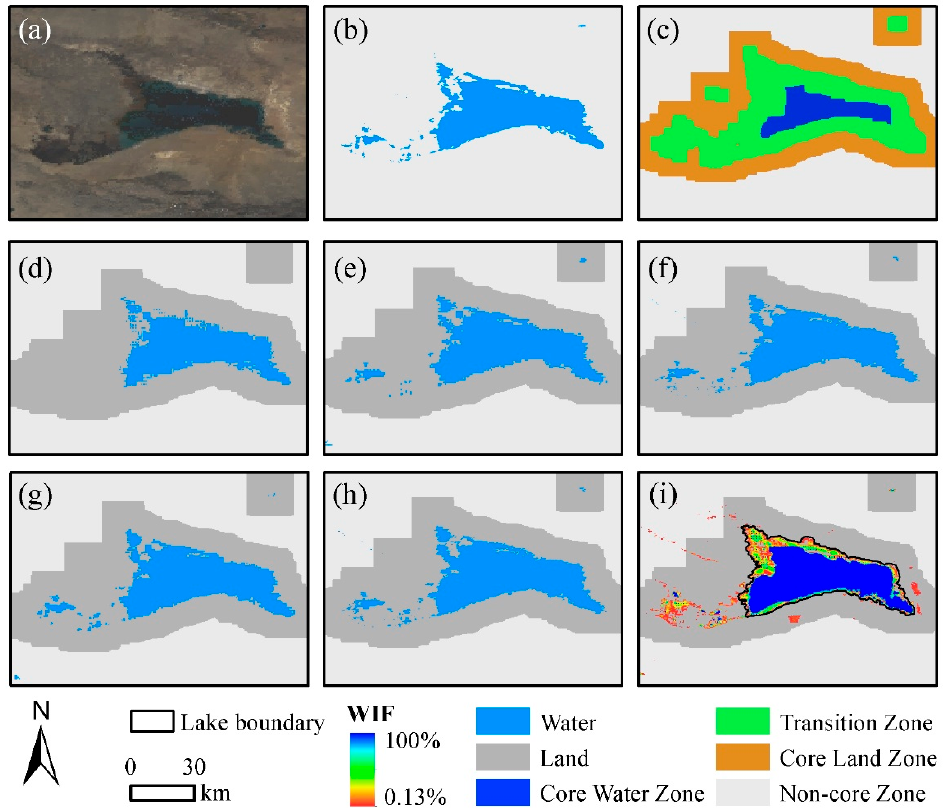
Figure 3. The example of automated extraction of water extent and water fusion result in Bosten Lake. ( a ) False-color composite (bands 1, 4, and 3) on 2,016,081th day; ( b ) the MOD44W water result; ( c ) the buffer, including CWZ, TZ, and CLZ; ( d , e ) water results of 2,016,081th and 2,016,089th days from MOD09A1, respectively; ( f ) the water result of 2,016,081th day from MOD13Q1; ( g , h ) fused water results of 2.016,081th and 2,016,089th days, respectively; and ( i ) the water inundation frequency (WIF) map.